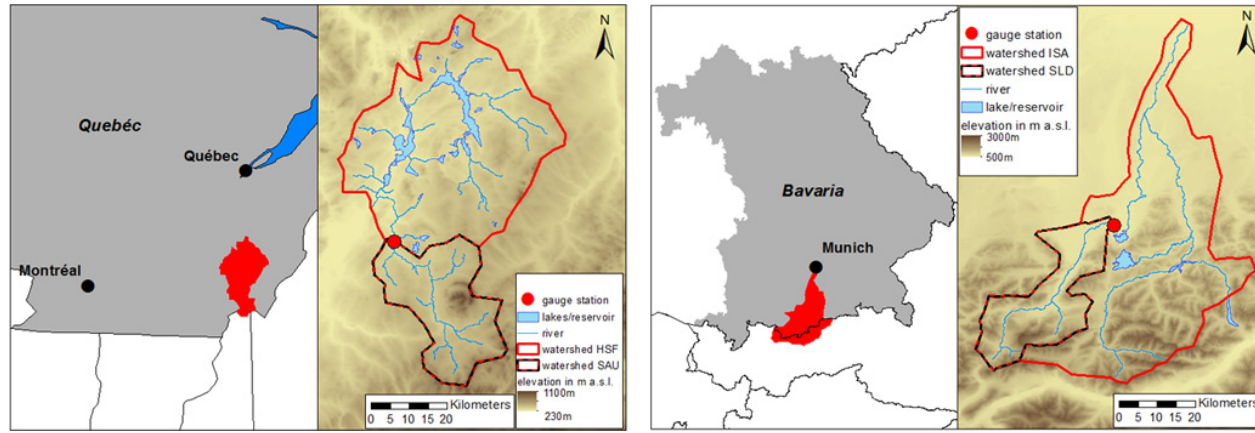
Fig. 1. Location and relief of the Haut-Saint-Franc¸ois (HSF, left) and the Upper Isar (ISA, right) watersheds including the drainage divide of the investigated head catchments of gauges Saumon (SAU) and Schlehdorf (SLD) from Vel´azquez et al. (2013).